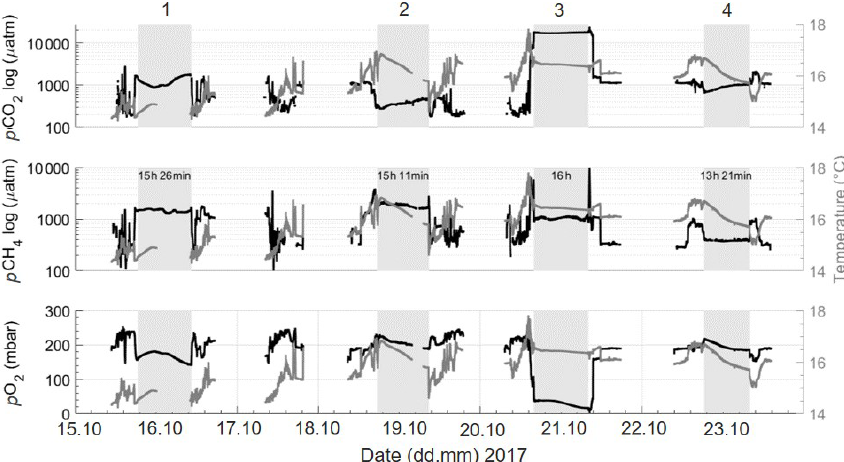
Figure 11. Sections acquired during the autumn limnic cruise. Rom3, showing p CO 2 (µatm; logarithmic scale), p CH 4 (µatm; logarithmic scale) and p O 2 (in mbar) and temperature (in ◦ C; grey) from the SBE across the entire deployment. Temperature is kept constant on the right y axis for direct changes to be noticed within each gas. Shaded areas and numbers (1–4) indicate periods of stationary observations when anchored in one location (see Fig. 3c1–4), with the station keeping durations in hours and minutes (shown in the middle row). Gaps in data collection refer to times when the systems were switched off.